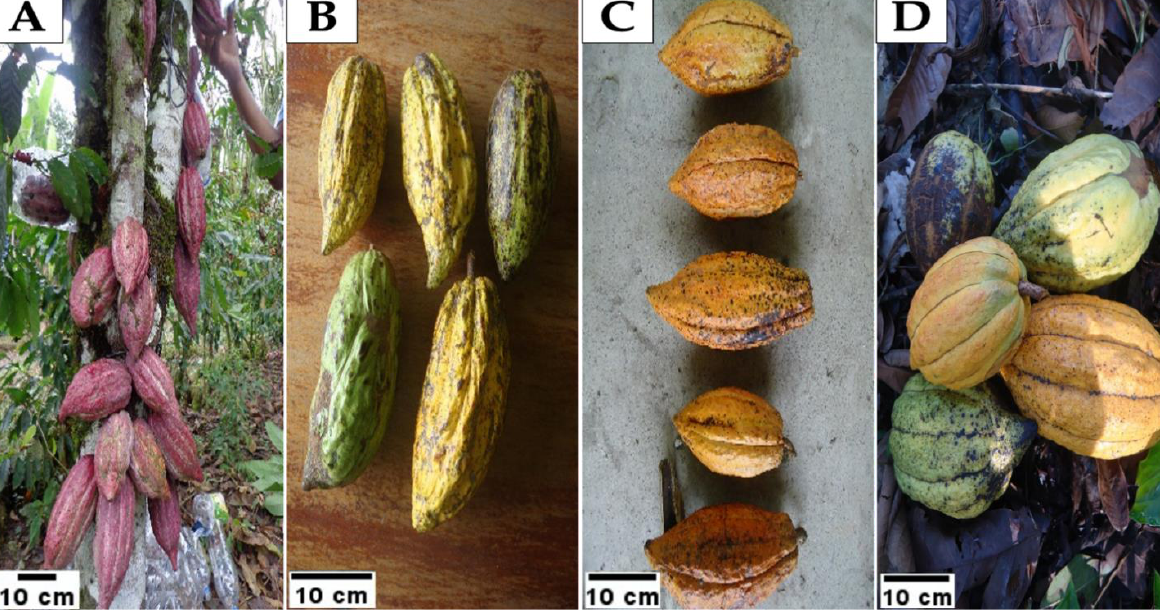
Figure 2. Pod samples of cacao Criollo from ( A ). Copán, ( B ). Intibucá, ( C ). Olancho, and ( D ). Santa Bárbara.